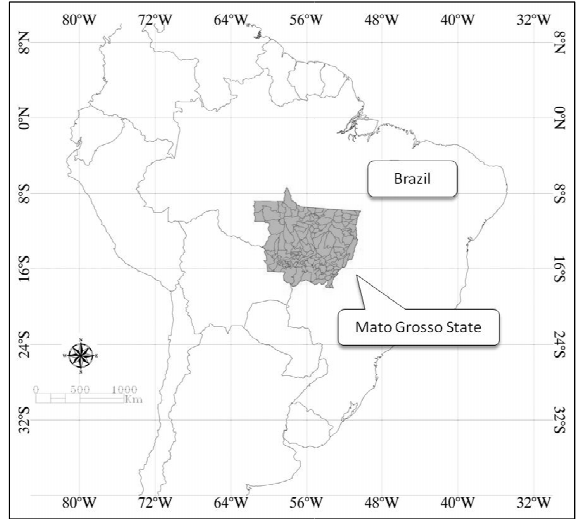
Figure 1.Mato Grosso State ,